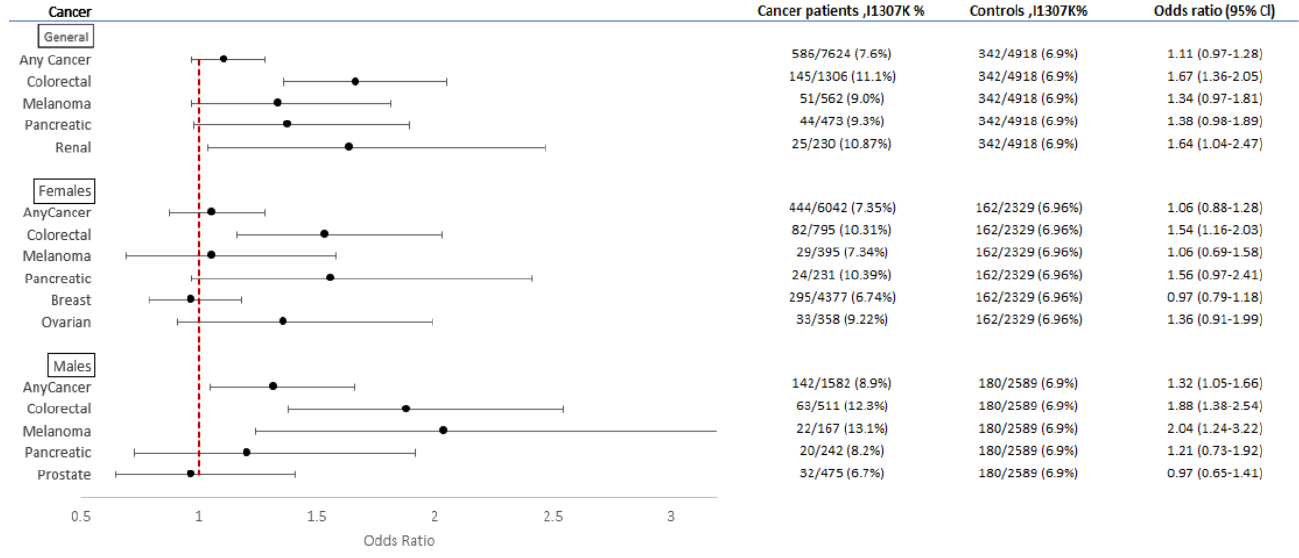
Figure 2. Forest plot representing the OR for different types of cancer according to the APC I1307K variant status in AJ.